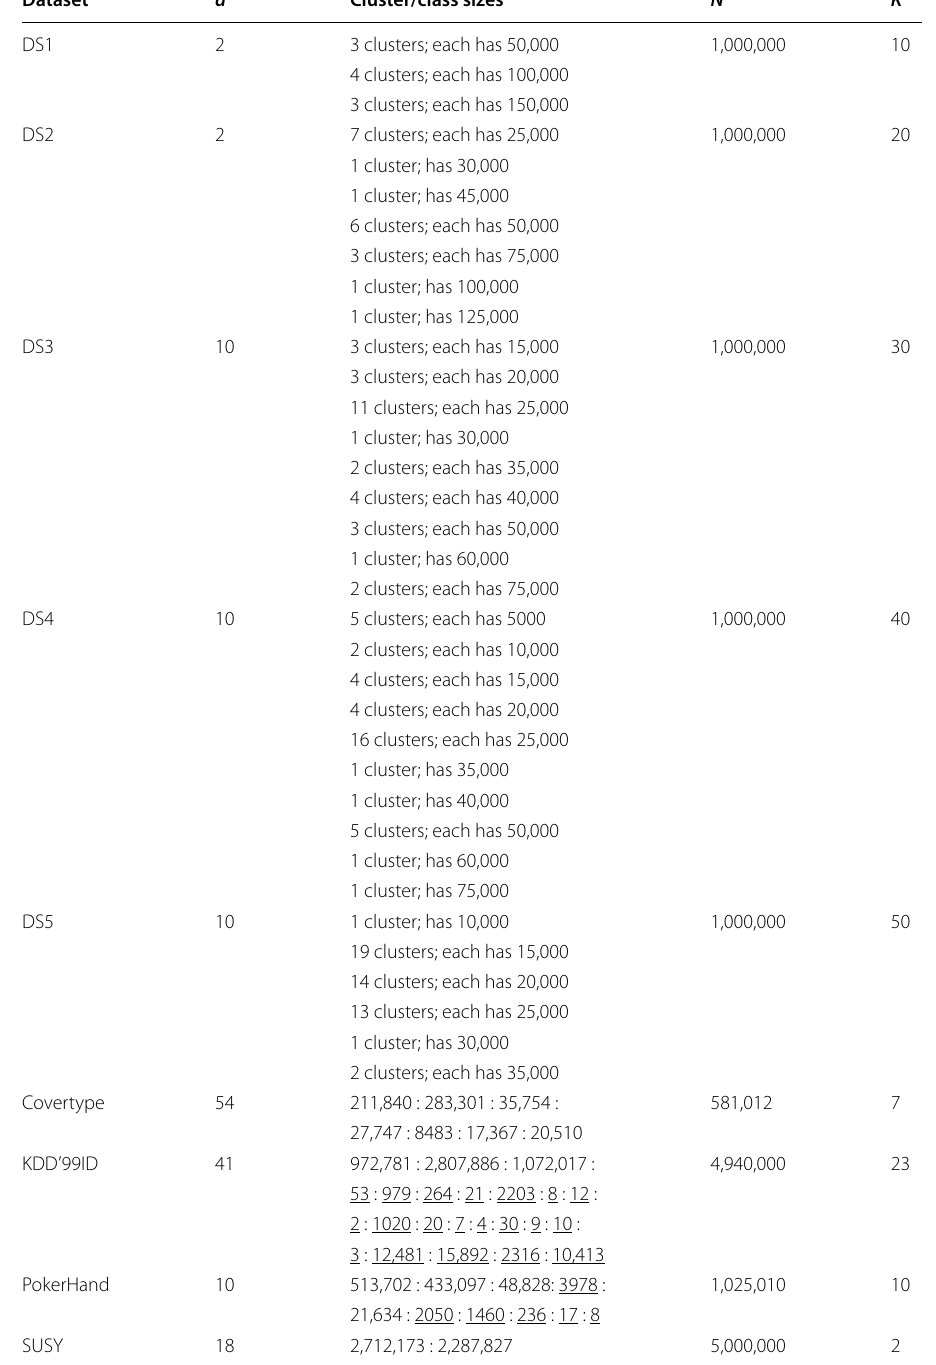
Table 1 Characteristics of the datasets ( d : dimensions, N : number of objects, K : number of clusters or